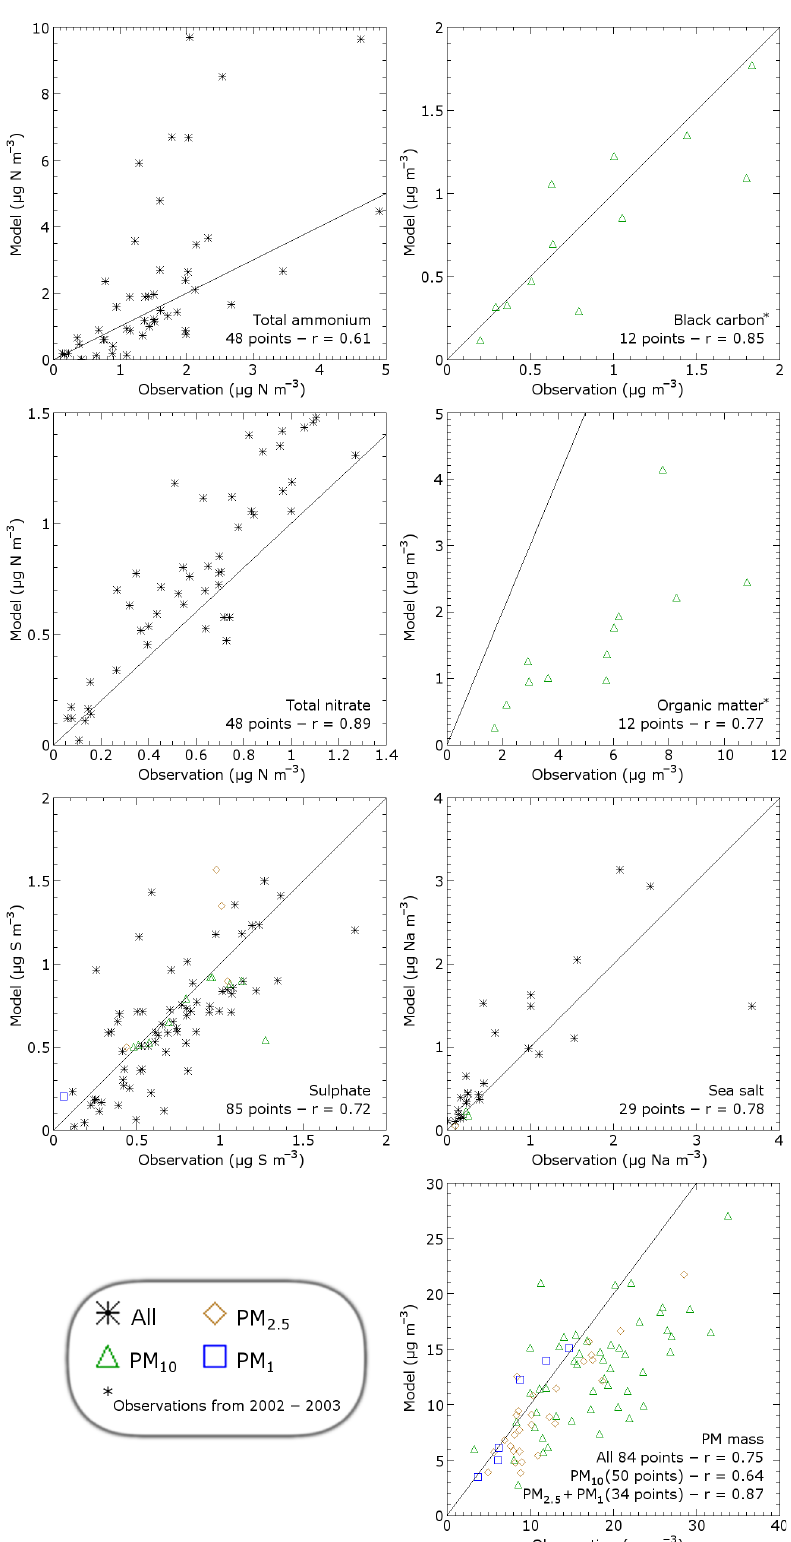
Fig. 3. Comparison between modelled and observed average concentrations over 2006 for total ammonium, total nitrate, sulphate, black carbon, organic matter, sea salt and total particulate matter at EMEP ground stations. The colours and shapes indicate the aerosol size